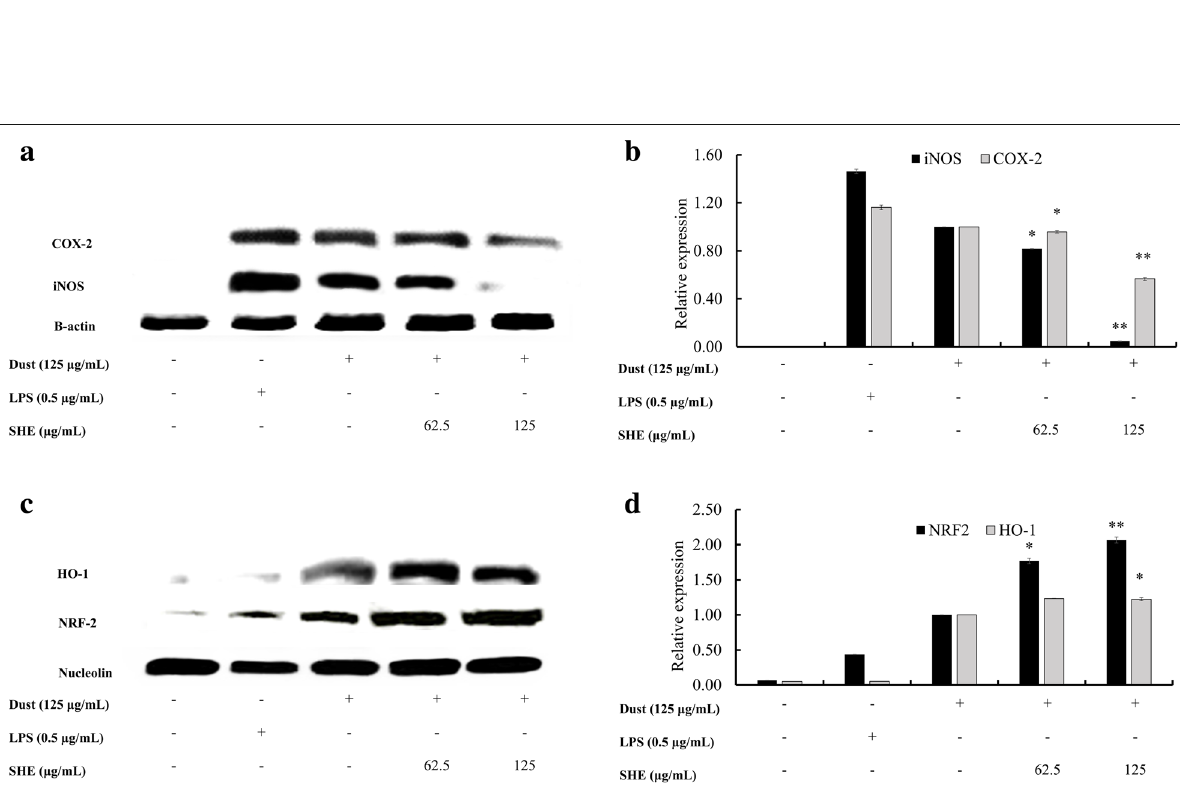
Fig. 5 Inhibitory effects of SHE on FD-induced inflammation-associated protein in RAW264.7 cells. ( a ) iNOS and COX-2 levels were determined using western blotting. ( b ) Quantitative data. ( c ) SHE-induced HO-1 and Nrf2 measured by western blot, and ( d ) relevant quantitative data. β -actin (for the cytoplasm) and nucleolin (for the nucleus) were used as internal controls. Quantitative data was analyzed using ImageJ software. Results are expressed as the mean ± SD of three separate experiments. * = p < 0.05 and ** = p <